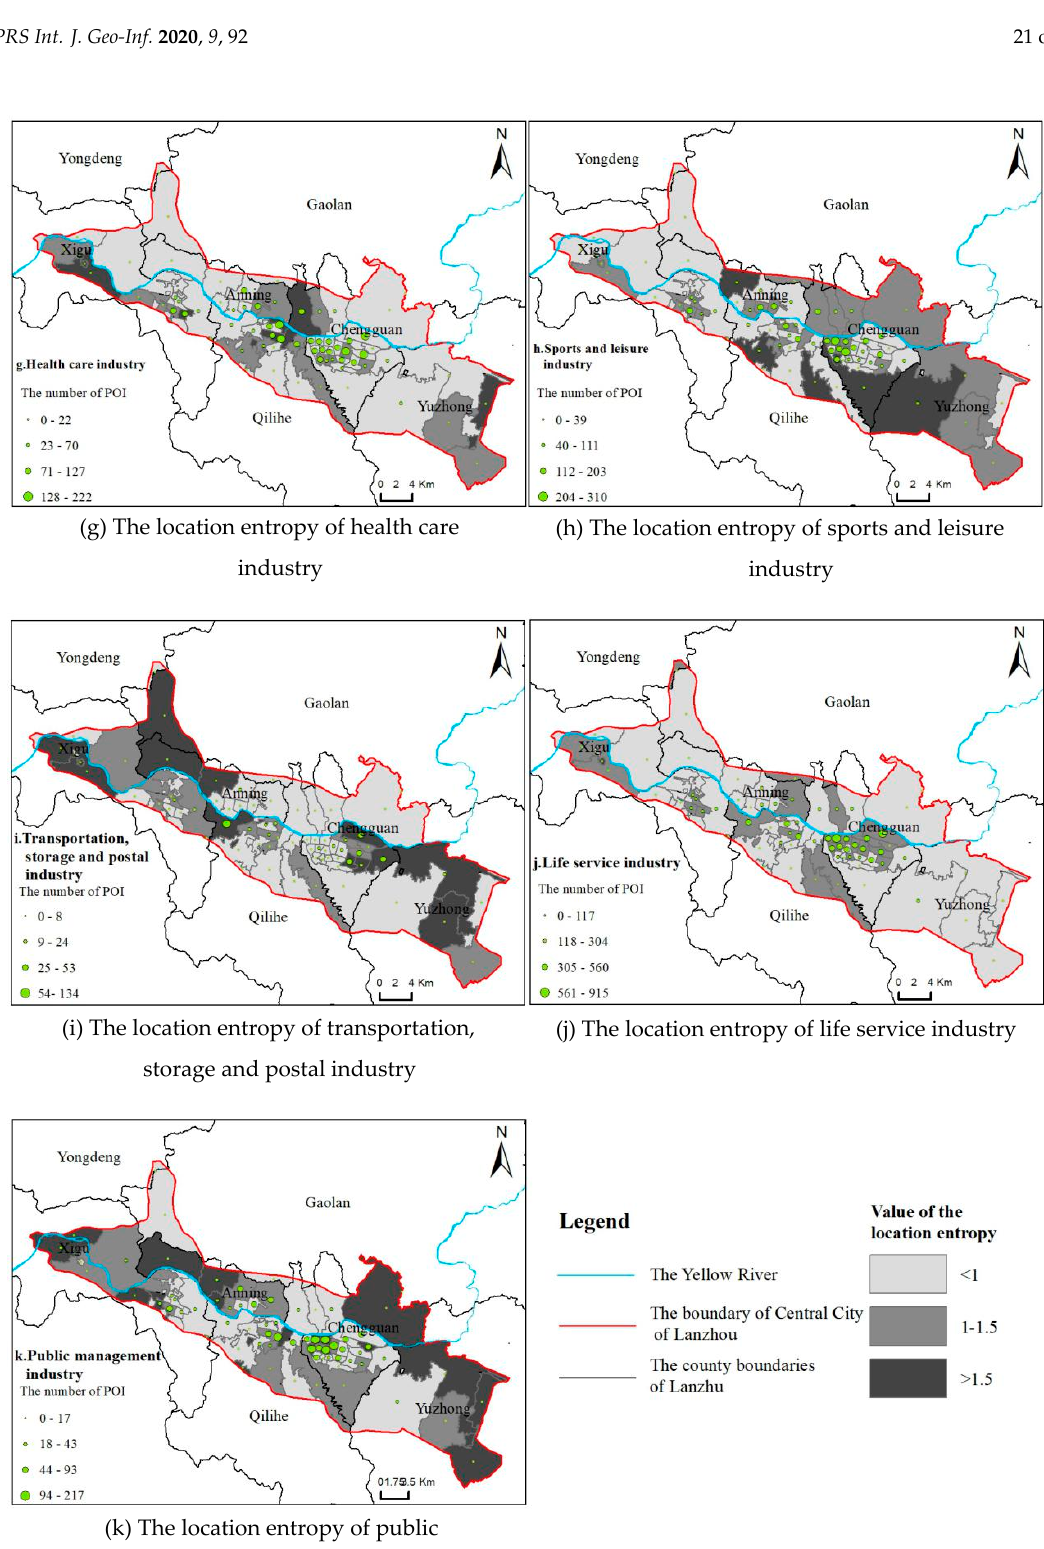
Figure 11. The distribution of location entropy in tertiary industry.